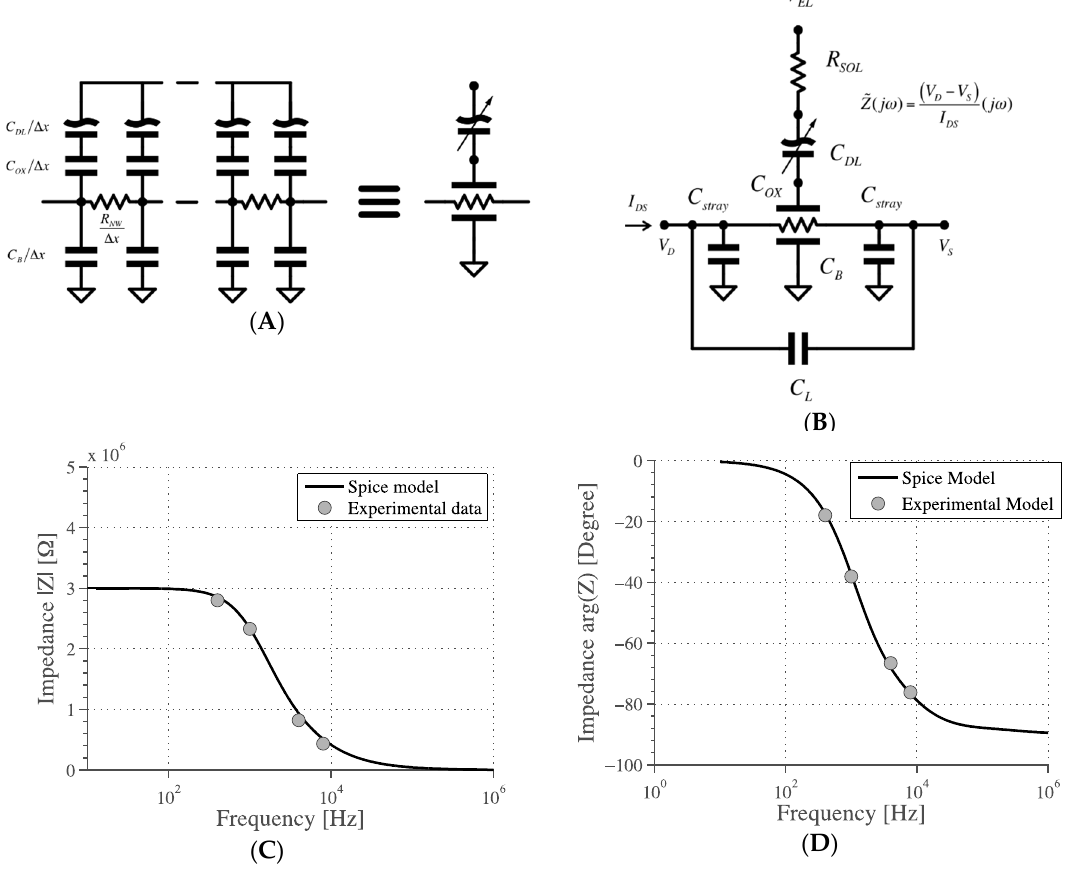
Figure 9. Distributed model of the nanowire channel ( A ) and AC sensing model ( B ). Comparison of the SPICE model with experimental data (bare nanowires) in impedance module ( C ) and phase ( D ). R NW = 3 M Ω , C L = 5 pF, C stray = 30 pF, C S = C OX //C DL = 15 pF, C B = 100 fF, R SOL = 2 M Ω .